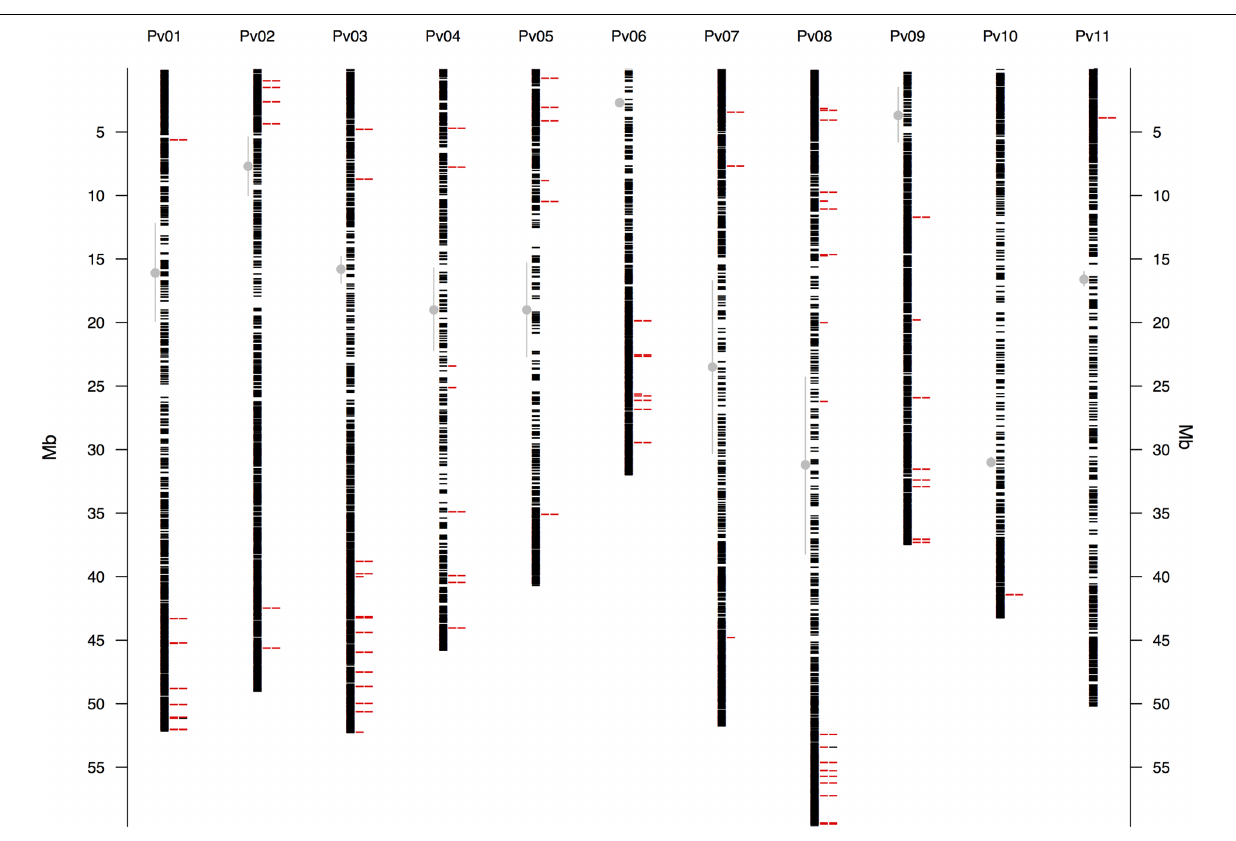
FIGURE 1 | Physical map of the 22,845 GBS-derived SNP markers for all 11 common bean (Pv) chromosomes. Physical position is shown in millions of base pairs (Mb). Each black hyphen corresponds to a SNP marker and the first column of red hyphens indicate markers associated with the bioclimatic-based drought index ( Figure 3 ), as calculated by Cortés et al. (2013). The second column of red hyphens marks the 75 associated regions that contained one gene ( Supplementary Table S3 ). The two black hyphens in this column at chromosomes Pv1 and Pv8 indicate associated regions that had two genes. Regions are defined here as overlapping 1,000 bp sections that flanked associated markers. Vertical gray lines with a central filled gray dot mark the centromeres according to Schmutz et al.